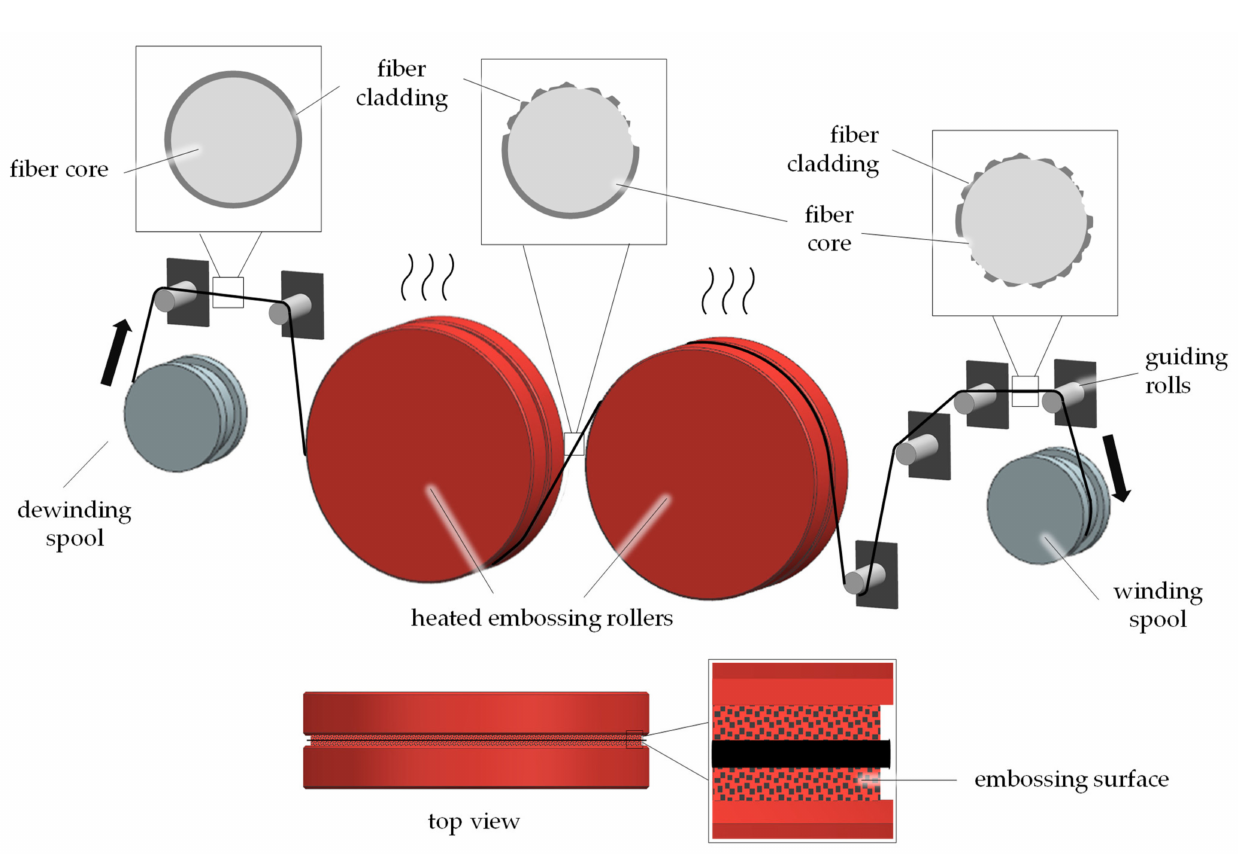
Figure 10. Process for thermal surface perforation via heated embossing